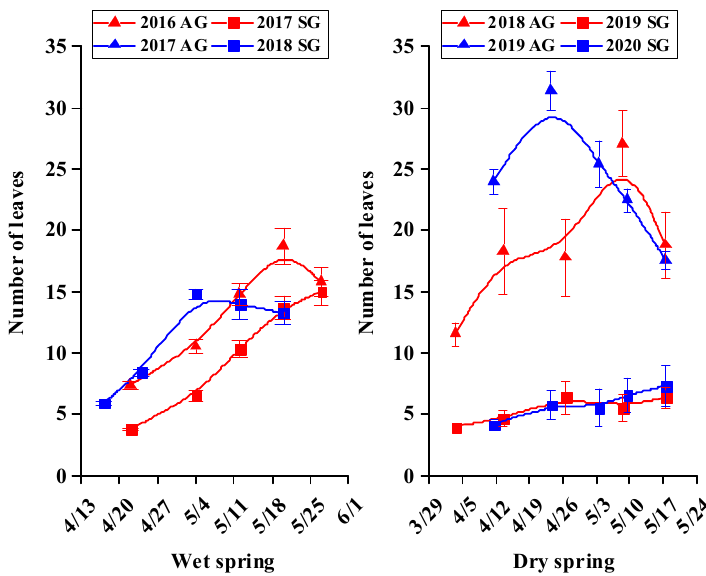
Figure 7. Increase in number of leaves of spring (SG)- and autumn (AG)-germinating plants of Erodium oxyrhinchum in wet ( left ) and dry ( right ) springs. The first three periods represent as vegetative stage, and the last two periods represent the reproductive stage. Vertical bars indicate standard errors of the means (n = 8).